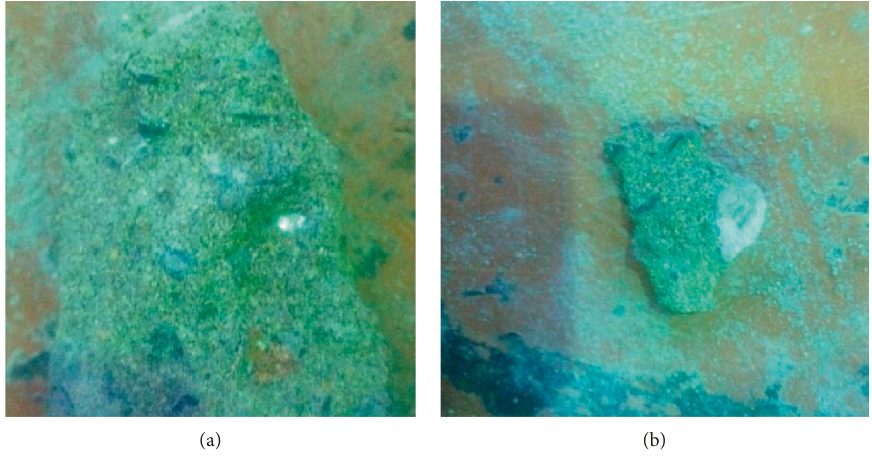
Figure 8: Picture inside the sample.